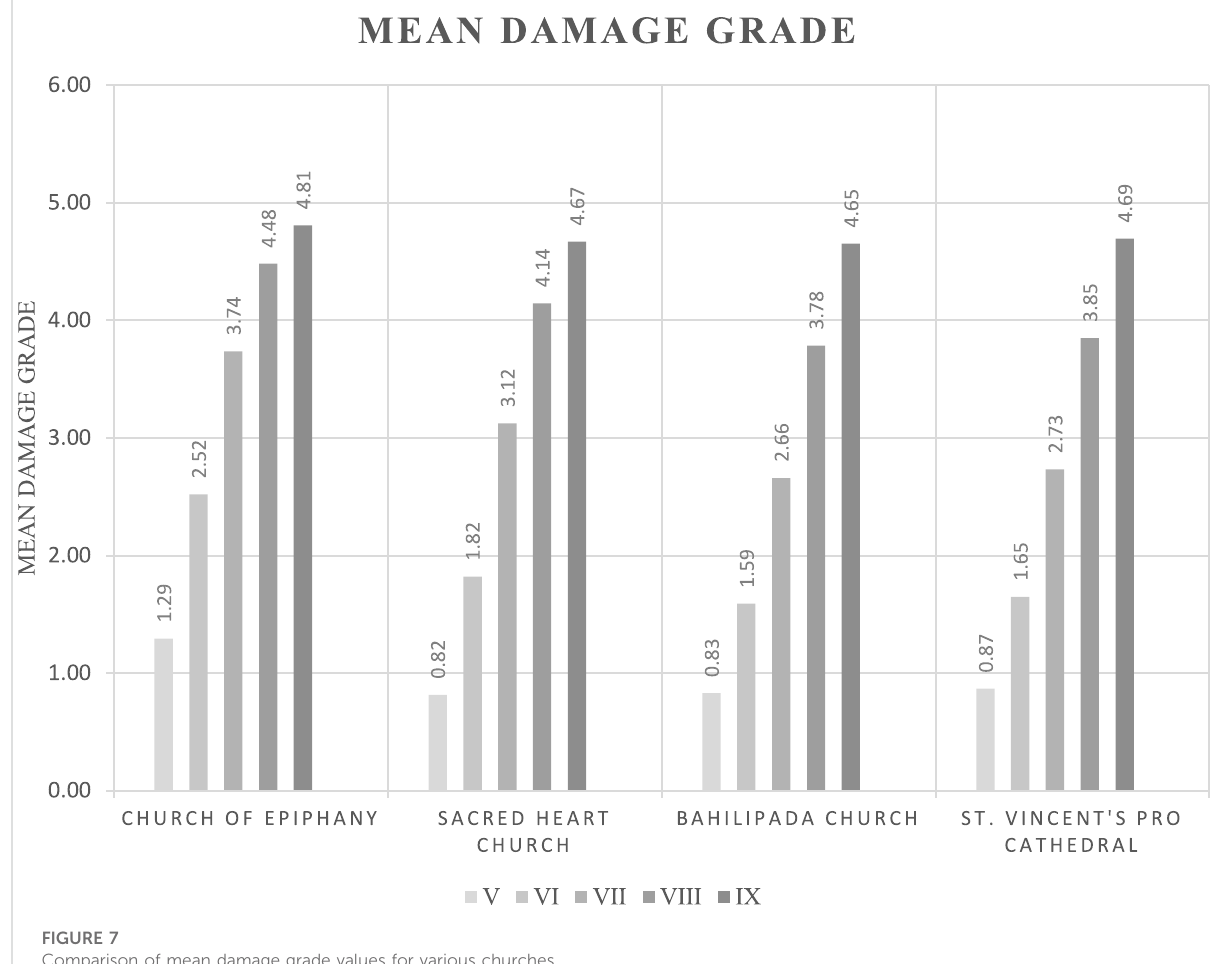
FIGURE 7 Comparison of mean damage grade values for various